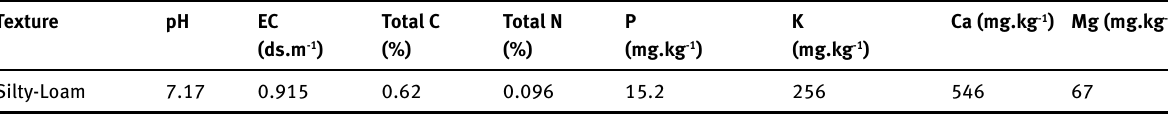
Table 1: Properties of the soil used in the experiment